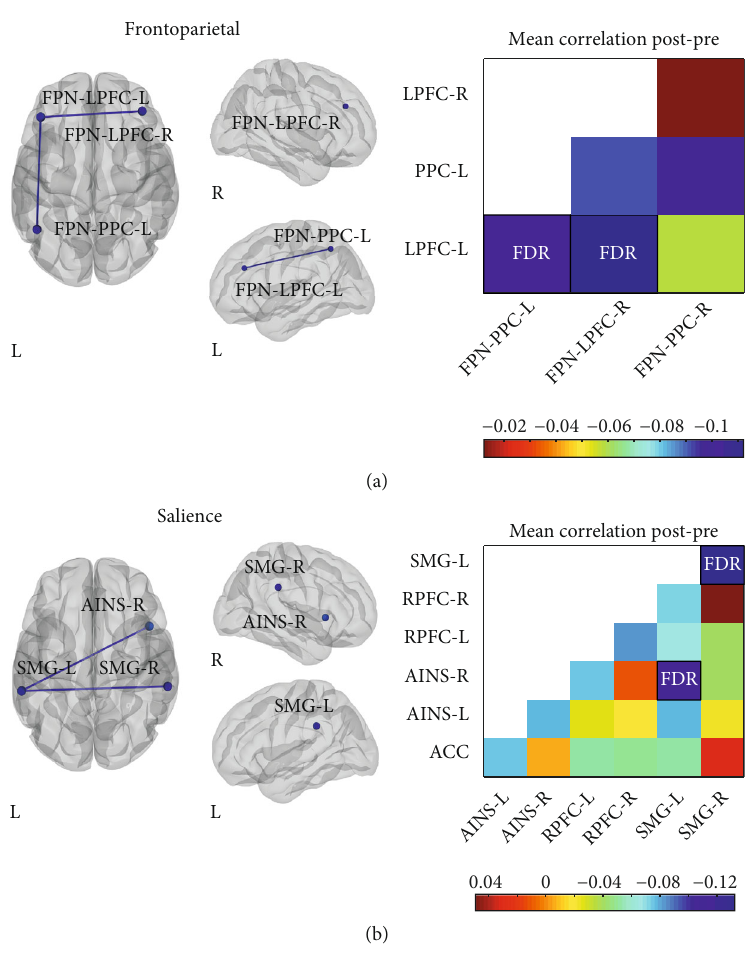
Figure 2: Changes in within-network connectivity induced by the neurological music therapy intervention. Nodes are overlaid on a rendered semitransparent brain generated using CONN. Connectivity matrices display the mean post- minus pre-intervention Fisher-transformed Z -score correlation values for each node. AINS: anterior insula; IPS: intraparietal sulcus; LAT: lateral; LPFC: lateral prefrontal cortex; MPFC: medial prefrontal cortex; OCC: occipital; PPC: posterior parietal cortex; RPFC: rostral prefrontal cortex; SMG: supramarginal gyrus; Sup: superior; R: right; L: